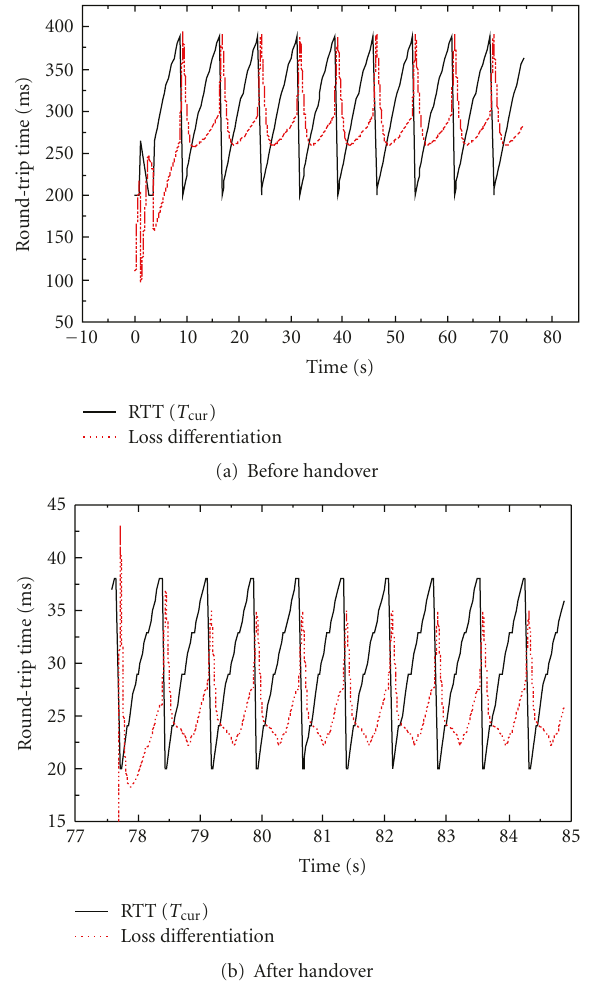
Figure 2: Loss di ff erentiation on vertical handover from 3G network to